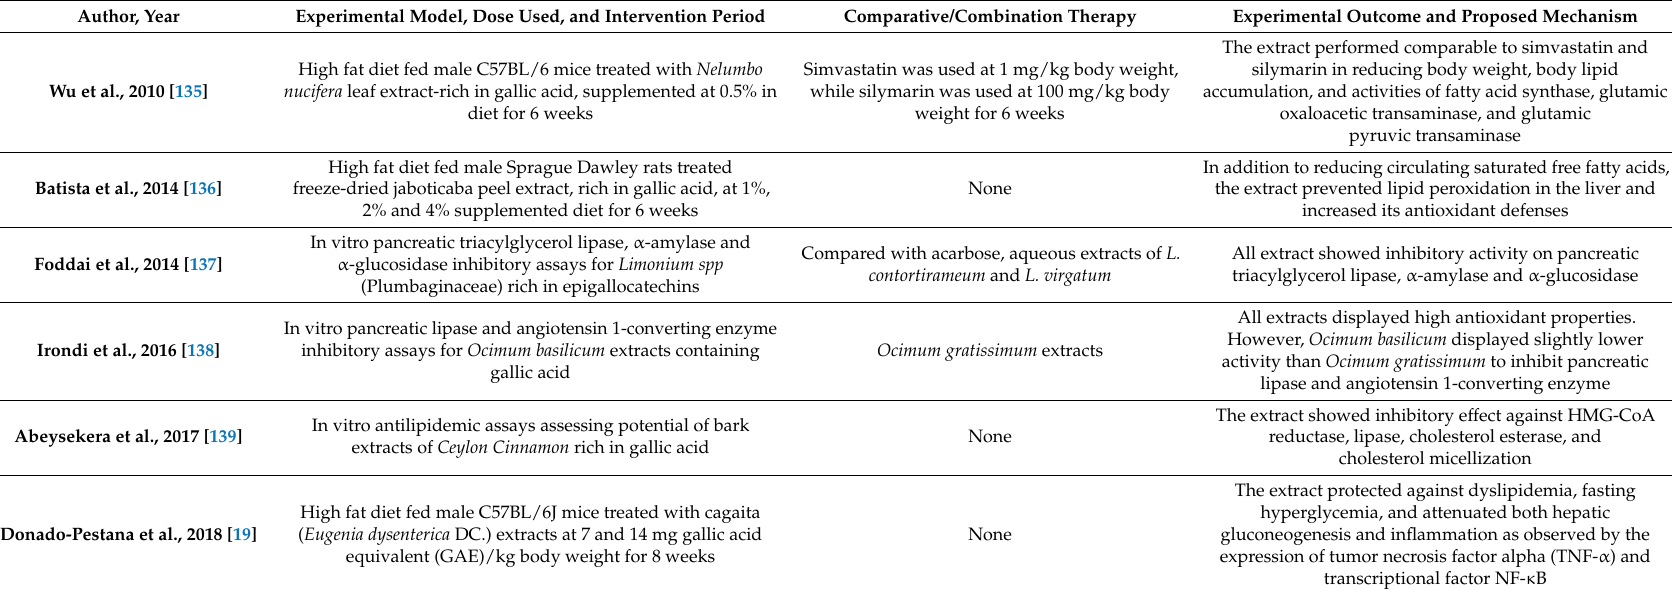
Table 4. Overview of studies reporting on the ameliorative effects of other gallic acid-rich plants against obesity-associated